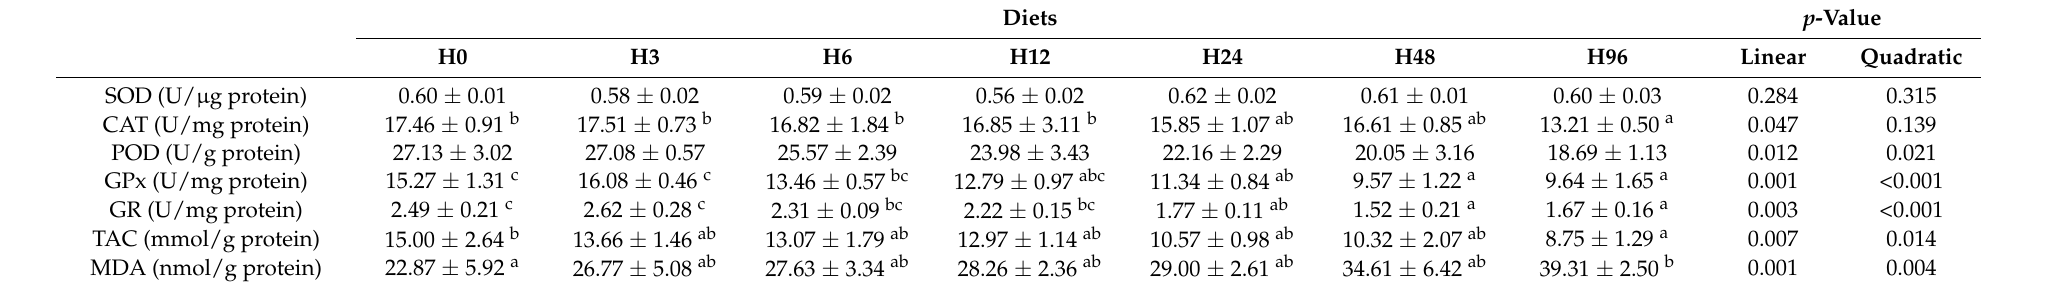
Table 7. Effect of dietary histamine content on the antioxidant-related index in the hindgut of the hybrid